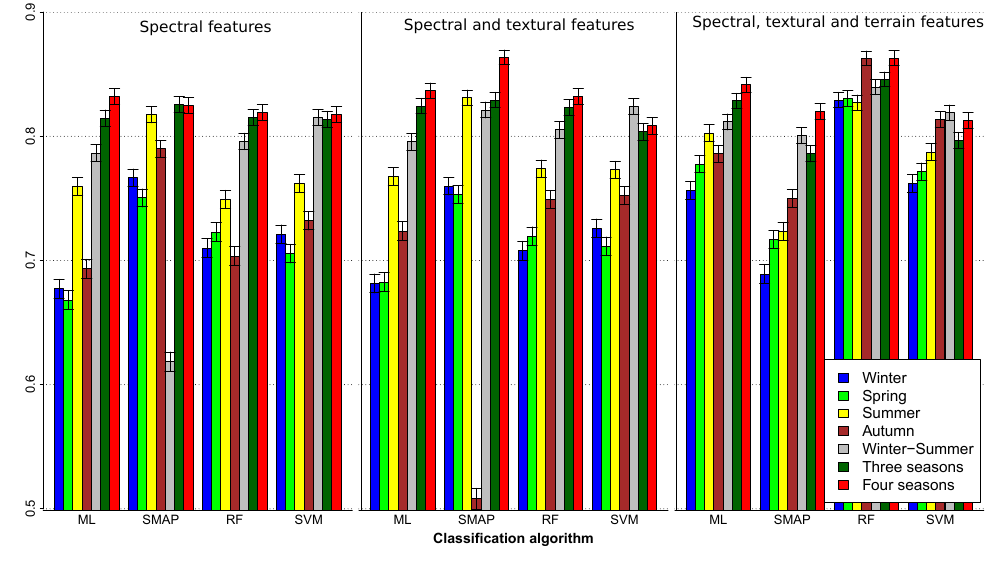
Figure 3. Kappa values and 95% confidence intervals obtained in the 2009 classification. Number of classifications: